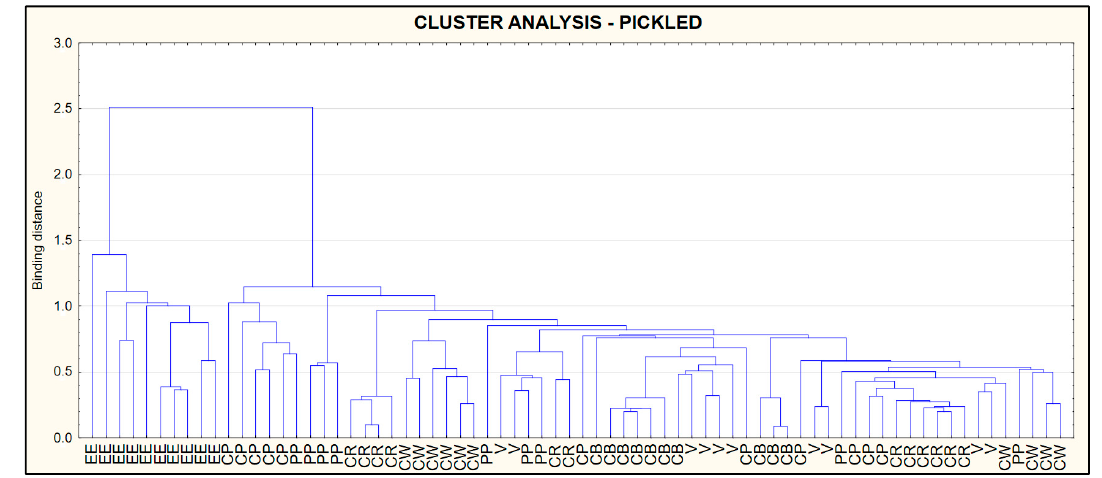
Figure 7. Dendrogram of similarity in protein, fat, salt, collagen and water in smoked fish. Foods 2020 , 9 , x FOR PEER REVIEW